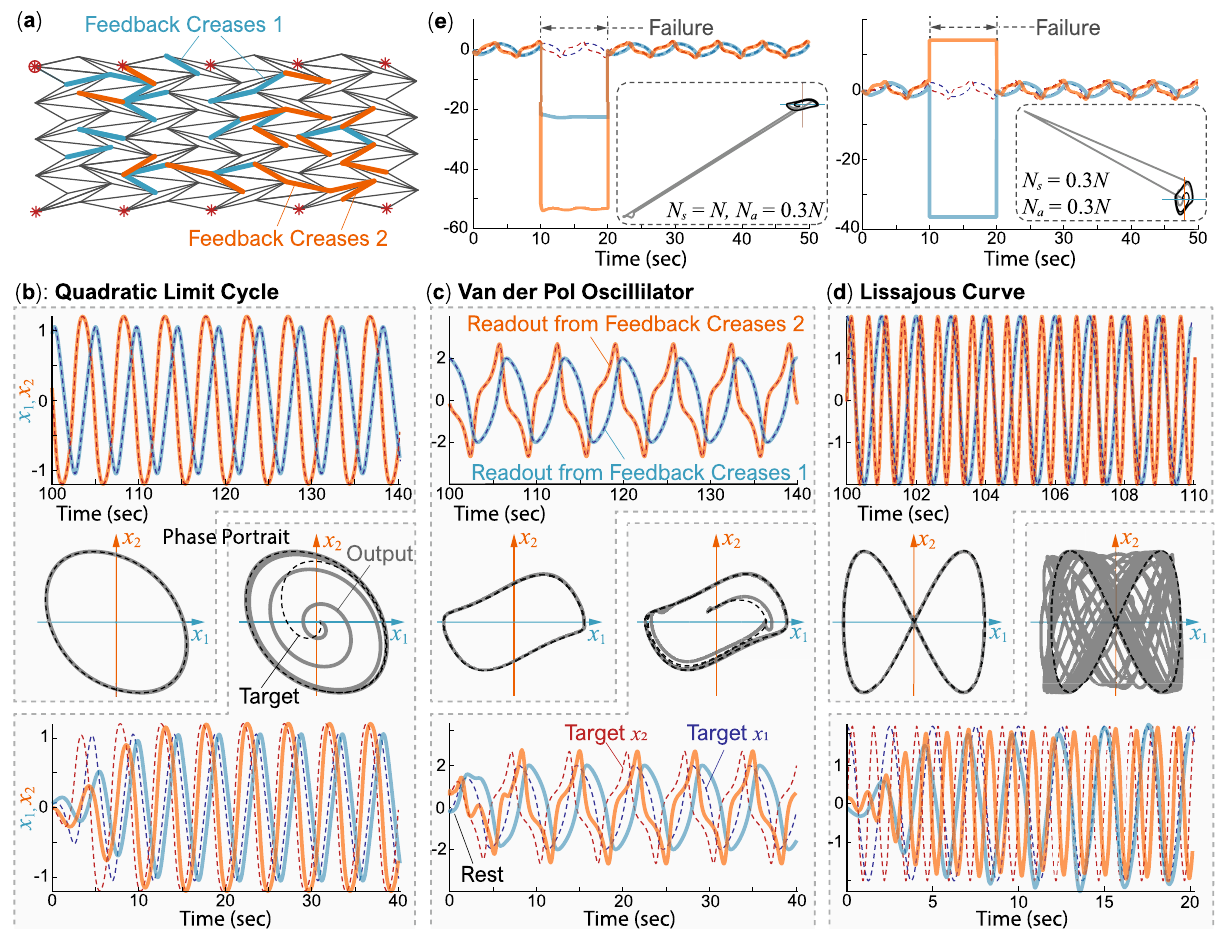
Figure 5. Stable pattern generation under closed-loop using the Miura-ori reservoir. ( a ) This task’s origami reservoir includes two groups of feedback creases required to generate 2D limit cycles. ( b – d ) The closed- loop trajectories of quadratic limit cycle, Van der Pol oscillator, and the Lissajous curve, respectively. In these plots, the first row of time responses shows the closed-loop output after 100s of training. The third row of time responses shows how the trained reservoir can recover the targeted limit cycles from an initial resting condition. The corresponding phase portraits are as shown in the second row. Here, the dashed curves are targeted trajectories, and the solid curves are the reservoir’s outputs. ( e ) Van der Pol limit cycle recovery after the temporary failure of sensor and actuator creases. The two simulations are the same except for the number of sensor creases ( N s = N for the first test, N s = 0.3 N for the second). The insert figures show the corresponding